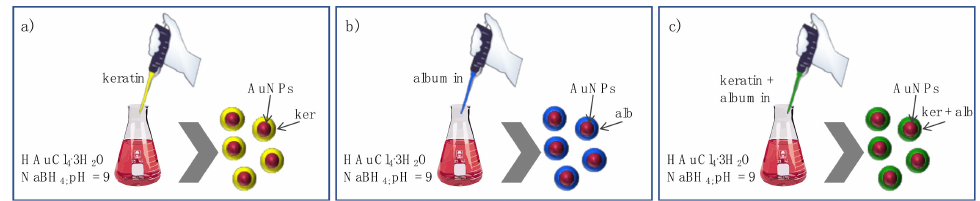
Figure 3. Schematic preparation procedure of ( a ) KP-AuNPs, ( b ) AP-AuNPs, and ( c )